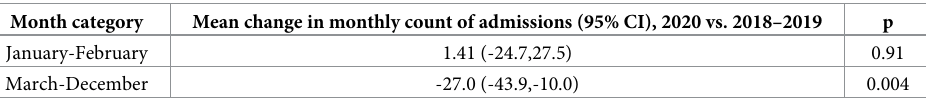
Table 2. Mean change in monthly count of admissions from autoregressive linear model by month category, 2020 vs.